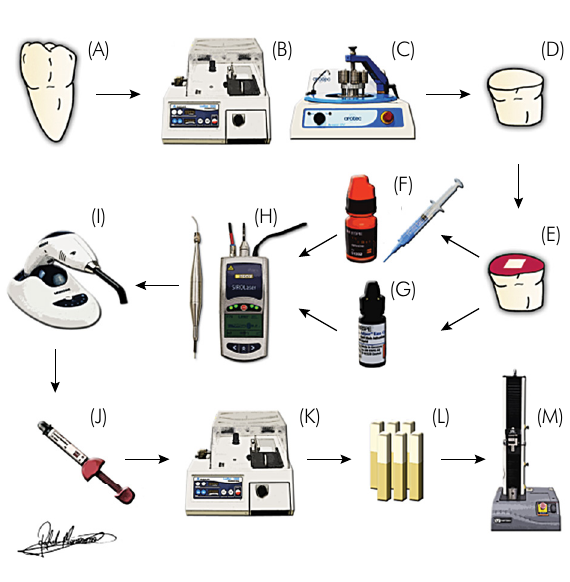
Figure 1. (A) Human third molar; (B) Sectioning machine; (C) Polishing machine; (D) Cut and polished specimen; (E) Speci- men with delimited testing area; (F) Two-step etch-and-rinse adhesive system; (G) One-step self-etch adhesive system; (H) Diode laser; (I) Light-emitting diode; (J) Microhybrid composite resin; (K) Sectioning machine; (L) Beam-shaped stick speci- mens; (M) Universal testing